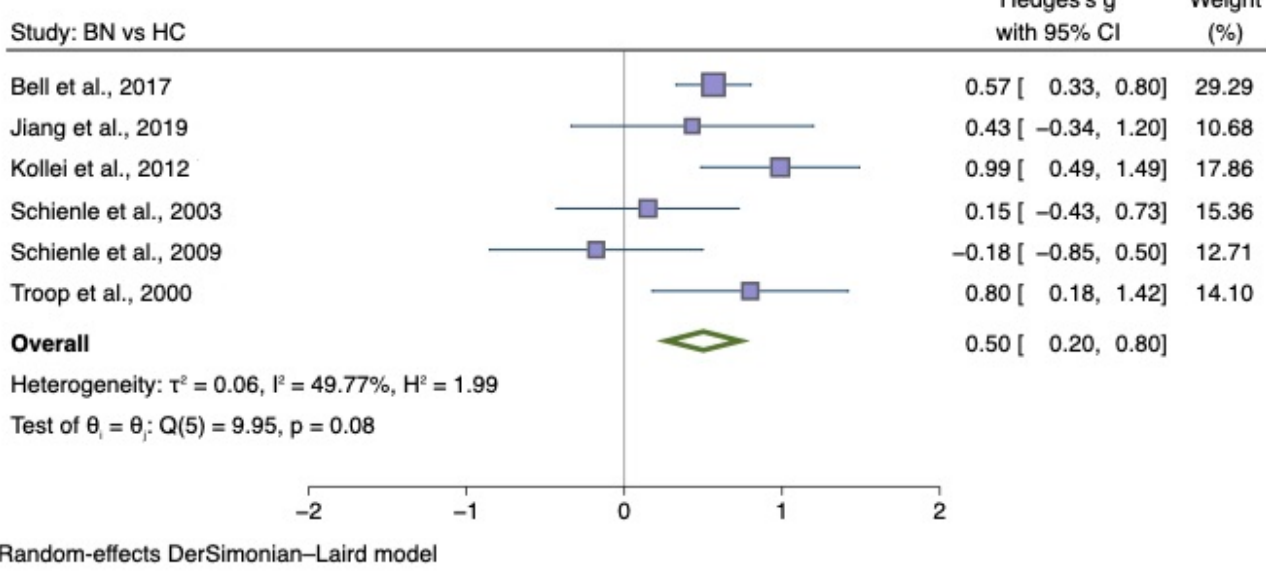
Figure 5. Forest plots of Hedges’ g in generic disgust sensitivity between BN participants and HCs from n = 6 studies; CI: confidence interval. Refs.